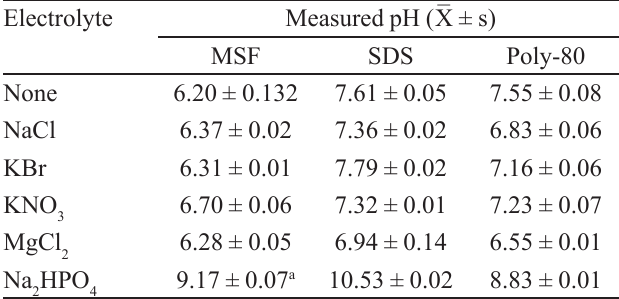
TABLE II - Measured pH values for mate saponin fraction (MSF), sodium dodecyl sulfate (SDS), and polysorbate 80 (Poly-80) solutions with and without electrolytes ( I = 0.024 M) at 20 ± 2 o C Electrolyte